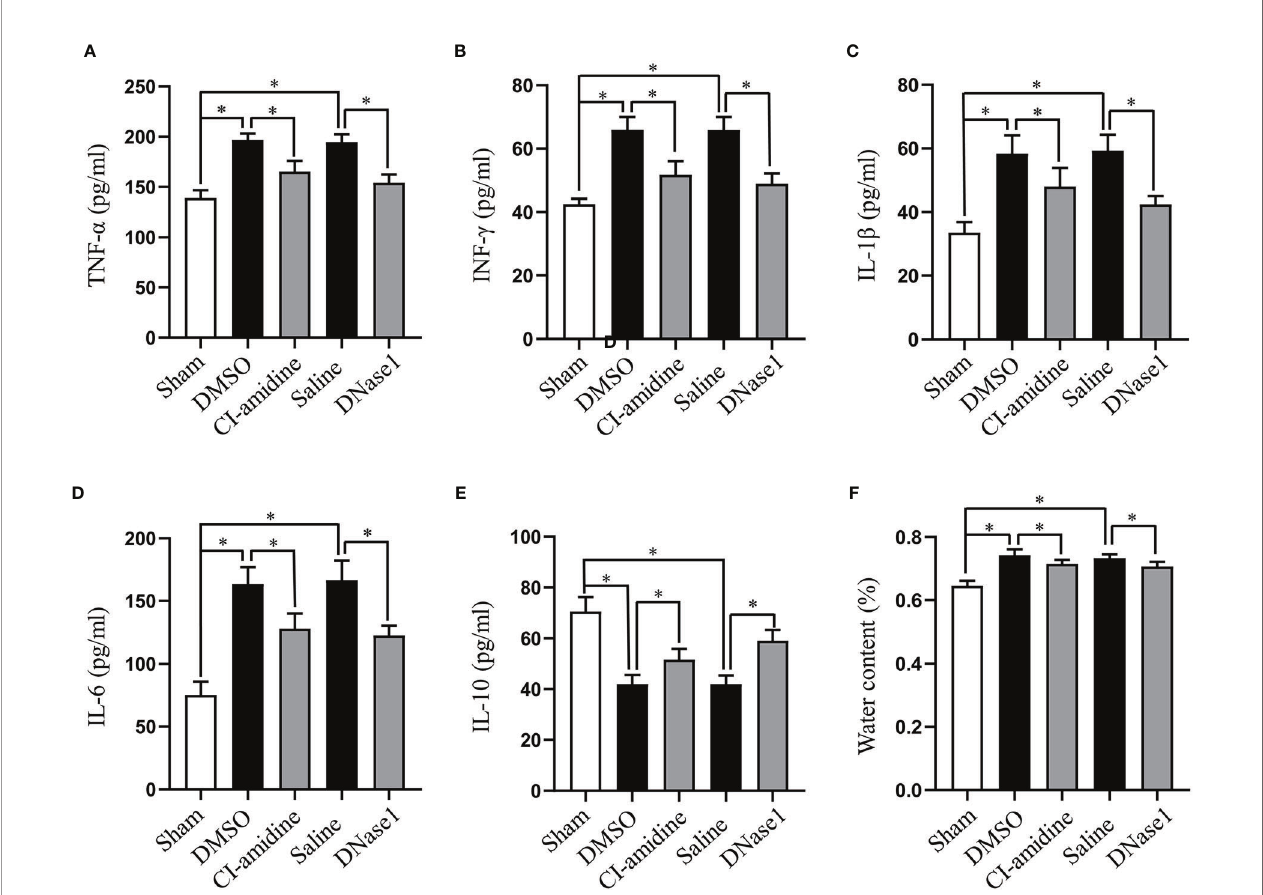
FIGURE 4 | Restricting NETs attenuates neuroin fl ammation and edema after SCI. Levels of (A) TNF- a , (B) IFN- g , (C) IL-1 b , (D) IL-6, and (E) IL-10 in injured spinal cord of each group at 24 h after SCI. (F) Water contents of injured spinal cord from each group at 24 h after SCI. Data are presented as means ± SD of n = 6 (* p <